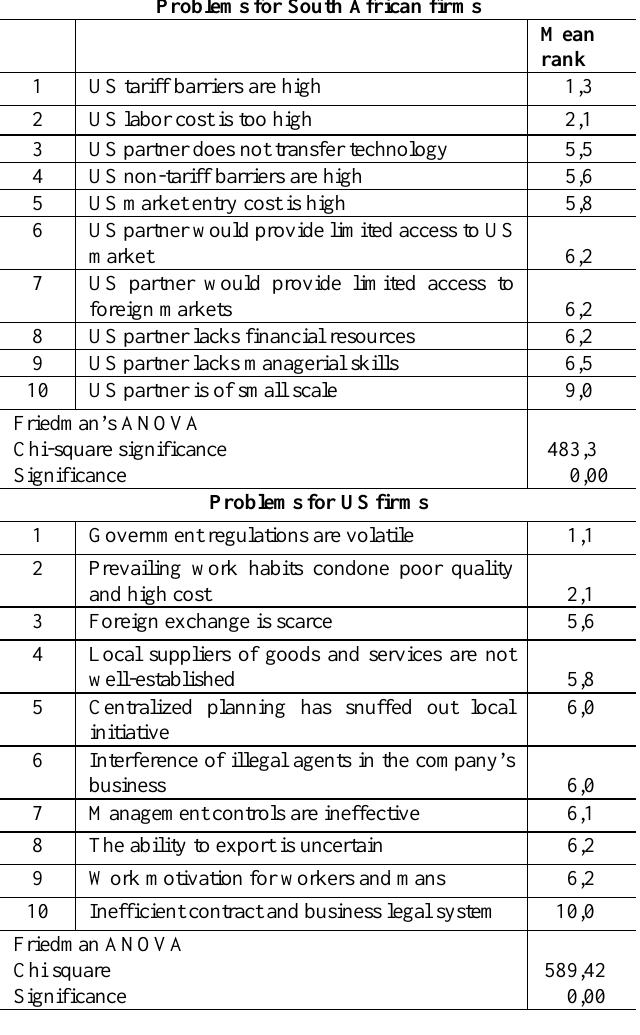
Table 2: Potential problems in South African-US joint ventures (N=103)